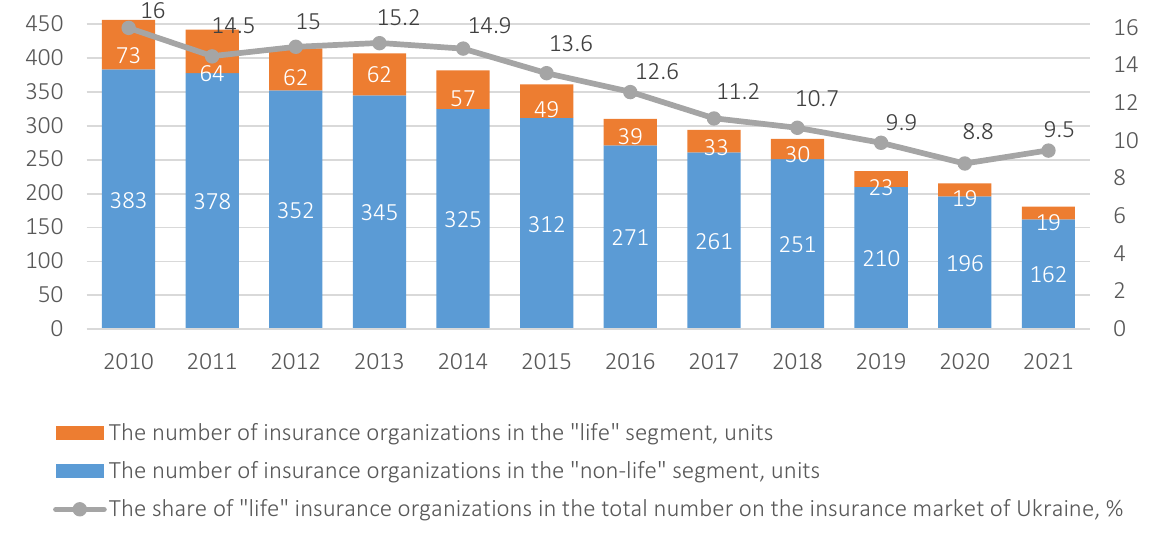
Figure 1. The number of insurance organizations at the insurance market by